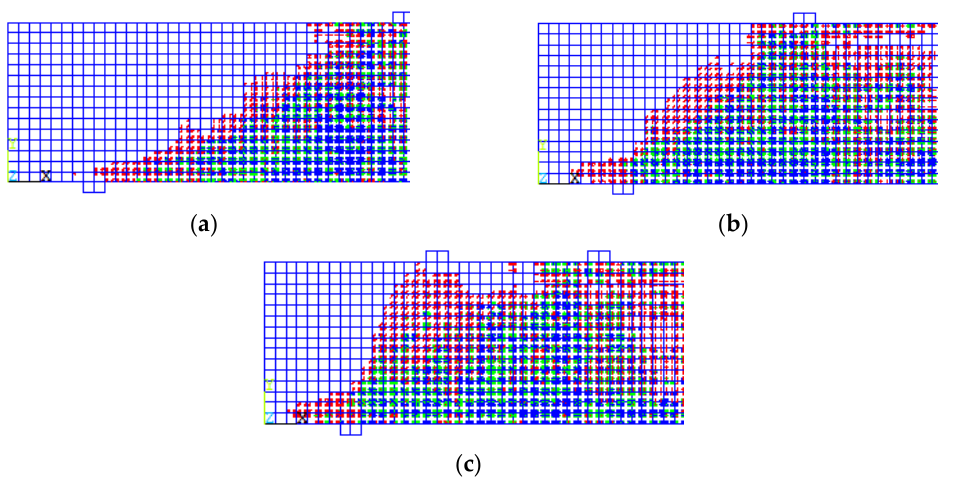
Figure 11. Crack Patterns for Group (3). ( a ) One-Pont Load. ( b ) Two-Point Loads ( c ) Distributed Load on Four Points.